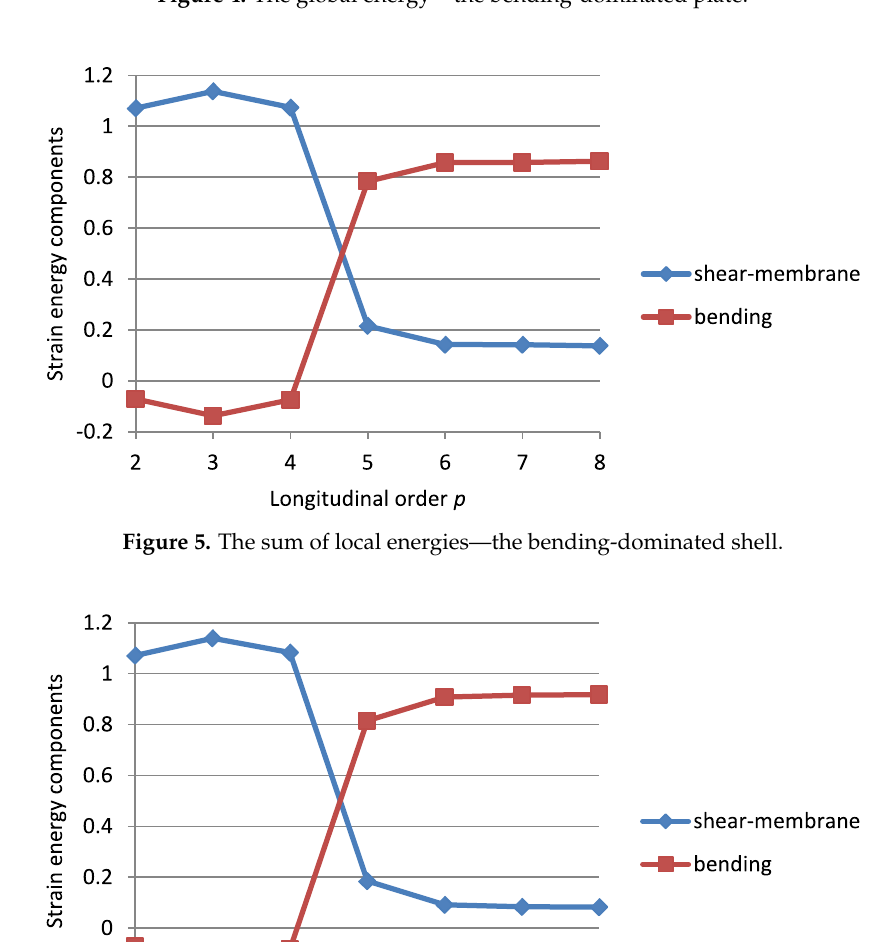
Figure 4. The global energy—the bending-dominated plate.